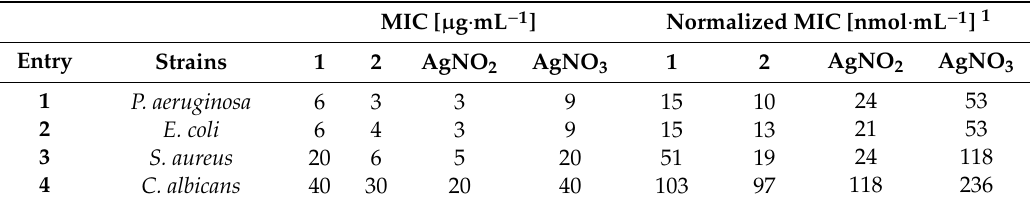
Table 1. Antimicrobial activity of 1 and 2 represented as minimal inhibitory concentration (MIC) and its normalized